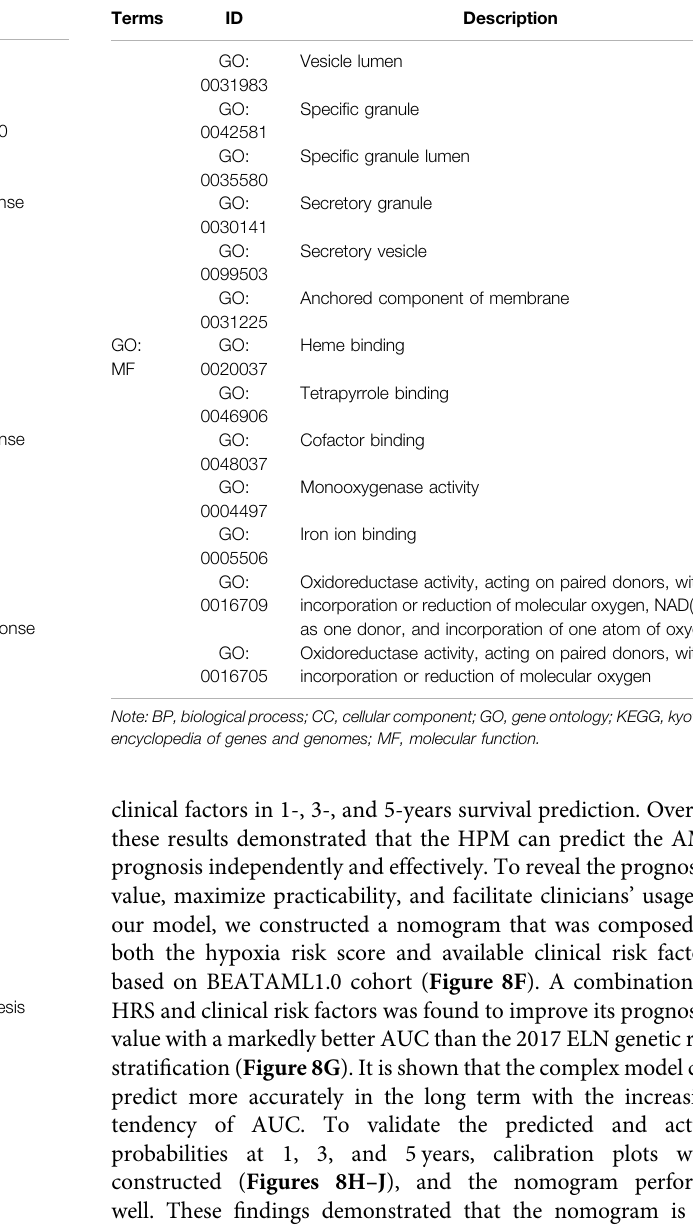
TABLE 2 | KEGG pathway enrichment analyses and GO functional annotation result.